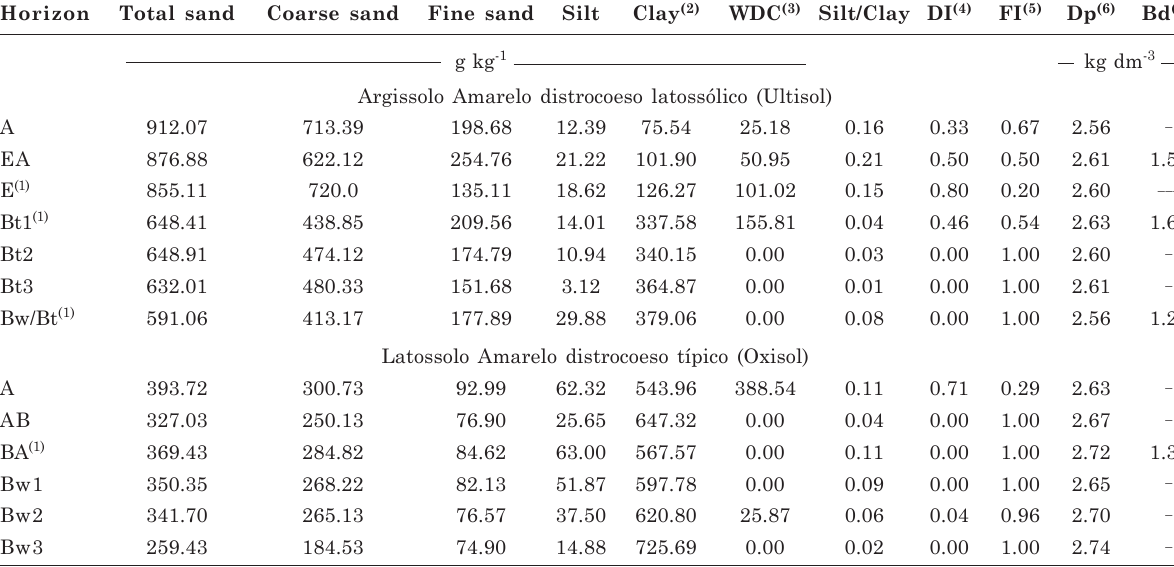
(1) Horizons selected for the study; (2) Method of hydrometer reading with clay fraction after 24 h of settling (Almeida, 2008); (3) Water dispersible clay; (4) DI (dispersion index) = 1 - FI; (5) FI (flocculation index) = [(clay - water-dispersible clay)/clay]; (6) Pd (particle density): volumetric flask method (Embrapa, 1997); (7) BD (bulk density): volumetric ring